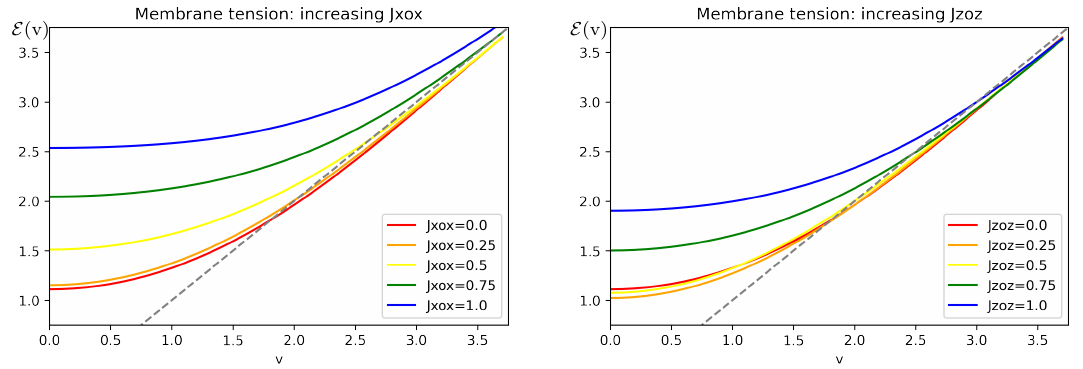
Figure 7 . Numerical estimation of the membrane tension function E ( v ) for various the spin chain with a single nonlocal coupling turned on. Left: the overall affect of increasing the J xox coupling is to raise the membrane tension function. Right: increasing the J zoz coupling initially has a small suppres- sive effect on the membrane tension function, but beyond J zoz ’ 0 . 5 it surpasses the J zoz = 0